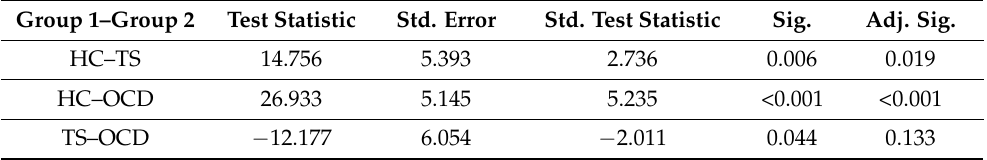
Table A7. Testing for significant group differences using the Bonferroni post-hoc test in the Beck Depression Inventory-II (BDI-II). Abbreviations: Adj. Sig., adjusted significance; HC, healthy control subjects; OCD, obsessive-compulsive disorder; p , asymptotic significance; Sig., significance; Std., standard; TS, Tourette syndrome.